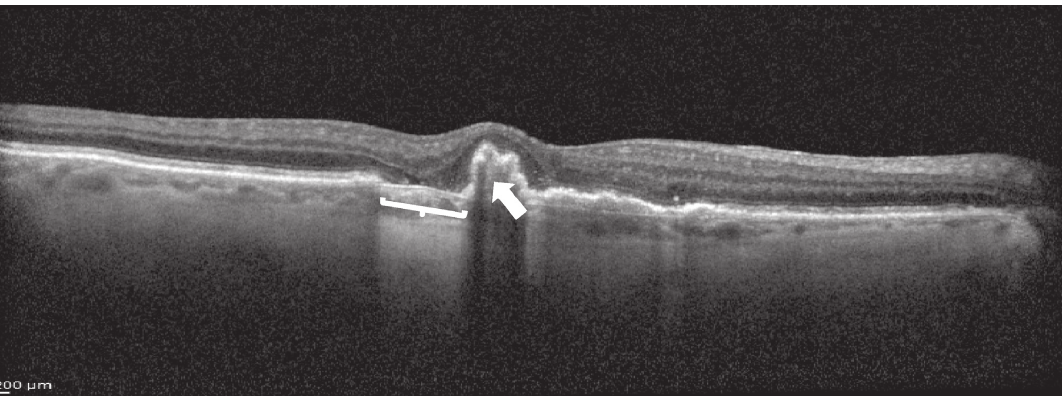
Figure 6: Structural OCT biomarkers: RPE tear (white bracket) and RPE layer retraction (white arrow).